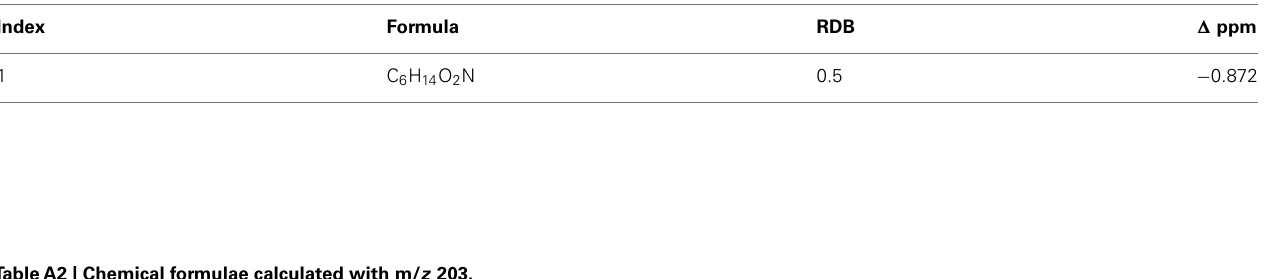
TableA1 | Chemical formulae calculated with m/ z 132.